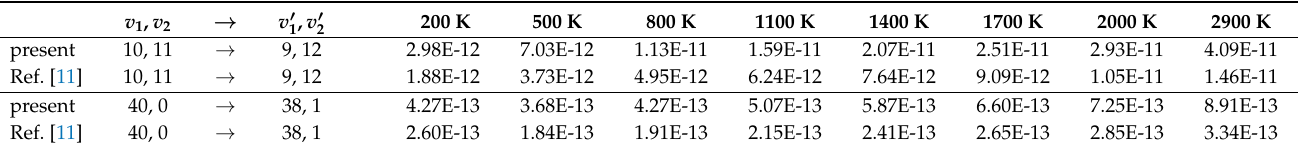
The dependence of the present PES on the intramolecular distance has been tested in ref. [18]: molecular polarizabilities of both molecules, N 2 quadrupole moment and CO permanent dipole moment depend on the corresponding bond lengths. Its accuracy might, however, slightly decrease for very elongated monomers. Furthermore, Morse potential and Morse wavefunctions also lose accuracy when describing very high vibrational states. Rate coefficients for processes involving vibrational states with v ≥ 35 might therefore present an overall uncertainty larger than 20%. However, we believe them to be sufficiently reliable (more than those available by extrapolation or first-order treatments) for such processes and to provide at least the correct qualitative trend in their variation. A comparison between some exemplary symmetric single quantum and asymmetric multiquantum near-resonant V–V rate coefficients calculated on the present PES and those of ref. [11] can be found in Table 4. The present values are a factor two larger ca., the discrepancy growing larger with temperature, which could be connected to the more repulsive short-range character of the present PES. Comparison of V–V rate coefficients (in cm 3 /s) calculated with the present PES and those of ref. [11] for (cid:0) (cid:1) + (cid:0) (cid:1) v (cid:48) v (cid:48) N 2 transitions. CO ( v 1 ) + N 2 ( v 2 ) → CO 2 1